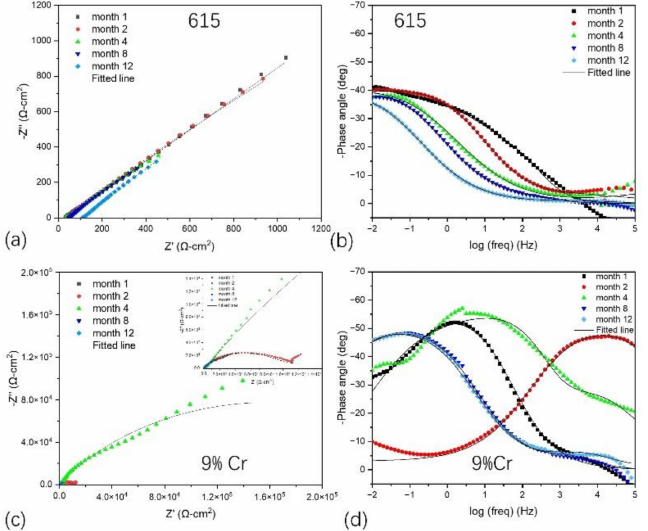
Figure 8. EIS results for both 615 and 9% Cr rebar in SCPS with 3.5 wt% NaCl as a function of time: ( a ) 615 Nyquist plot, ( b ) 615 Phase angle plot, ( c ) 9% Nyquist plot, ( d ) 9% Phase angle